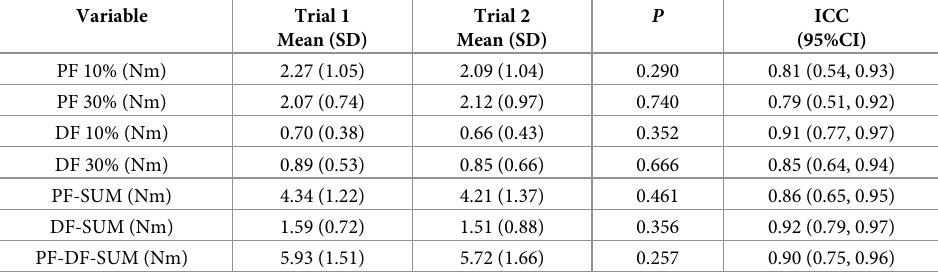
Table 1. Reliability values for force sense test